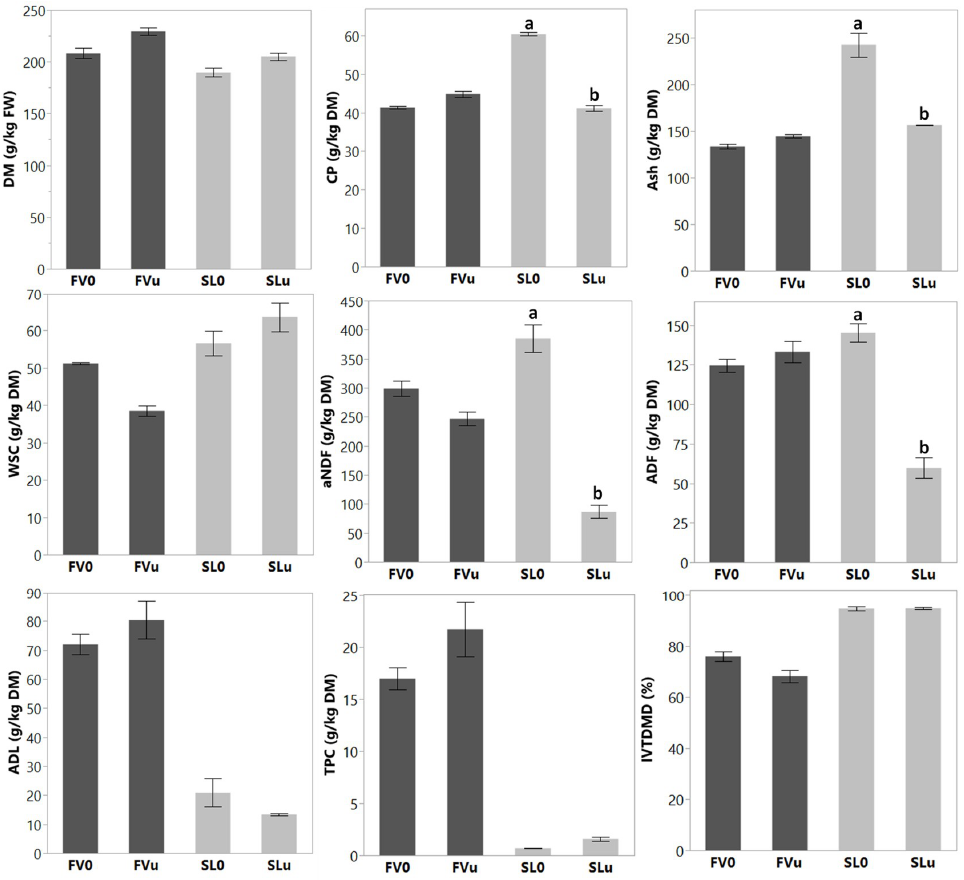
Figure 1. The chemical composition and IVTDMD of Fucus vesiculosus (FV: dark grey) and Saccharina latissimi (SL: light grey) before (0) and after ensiling (u: no inoculant). DM = dry matter; CP = crude protein; WSC = water soluble carbohydrate; aNDF = neutral detergent fibre; ADF = acid detergent fibre; ADL = acid detergent lignin; TPC = total phenolic content; IVTDMD = in vitro true dry matter digestibility. a,b Means within the same species with different lowercase letters are significantly different ( p < 0.05) .